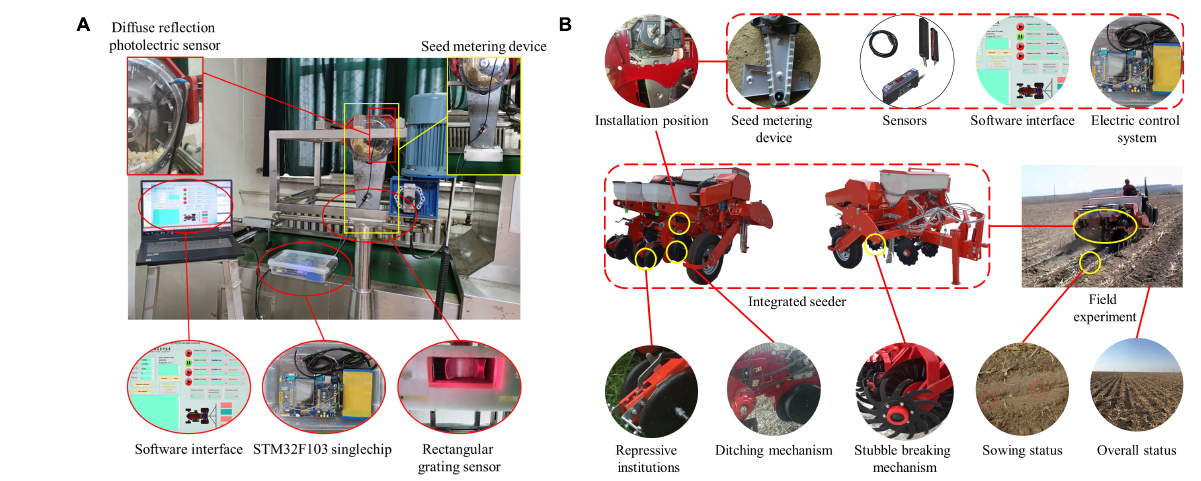
FIGURE 8 | Experiment. (A) Bench experiment. (B) Field experiment.